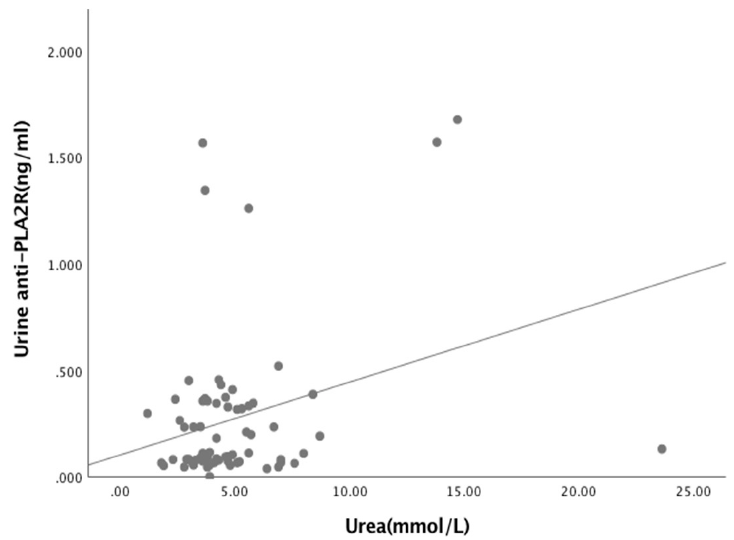
Figure A6. Relationship between Urine anti-PLA 2 R and serum Urea (R = 0.201, p <